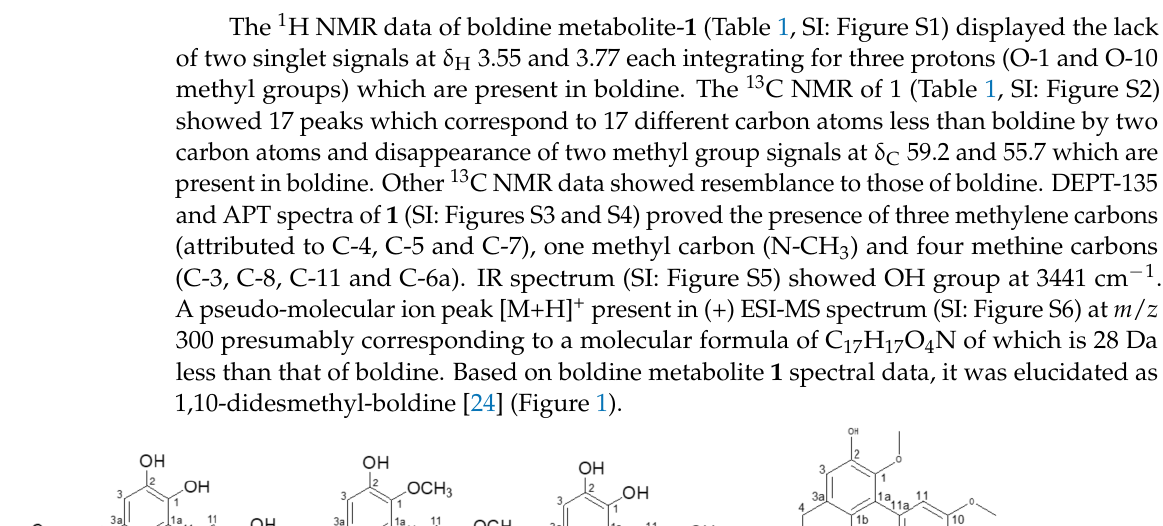
The 1 H NMR data of boldine metabolite- 1 (Table 1, SI: Figure S1) displayed the lack of two singlet signals at δ H 3.55 and 3.77 each integrating for three protons (O-1 and O-10